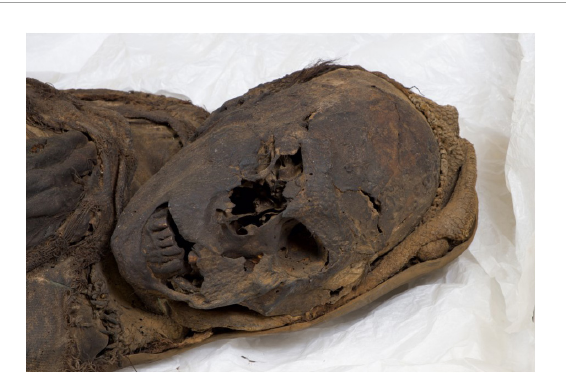
FIGURE7 The Delémont male mummy: view of the face and aspects of the upper body half from the right side.